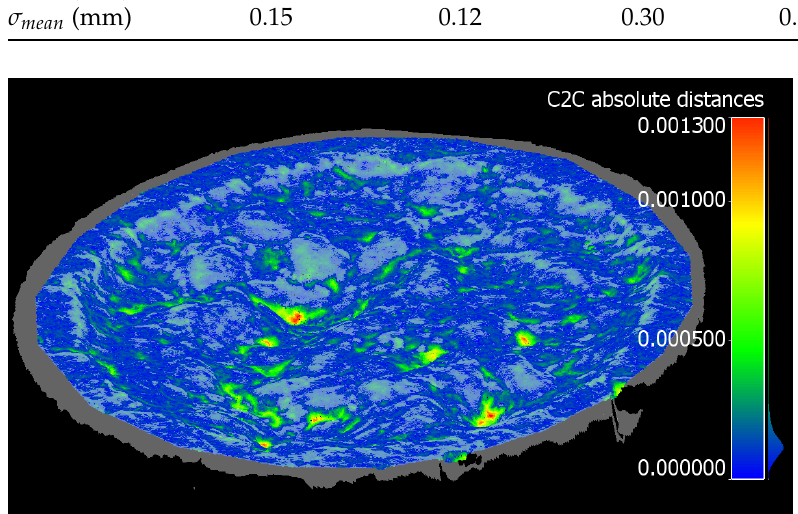
Figure 4. Difference image showing distance to reference model of pavement sample 3, as measured using high-resolution photogrammetry. Reference model is pictured as transparent